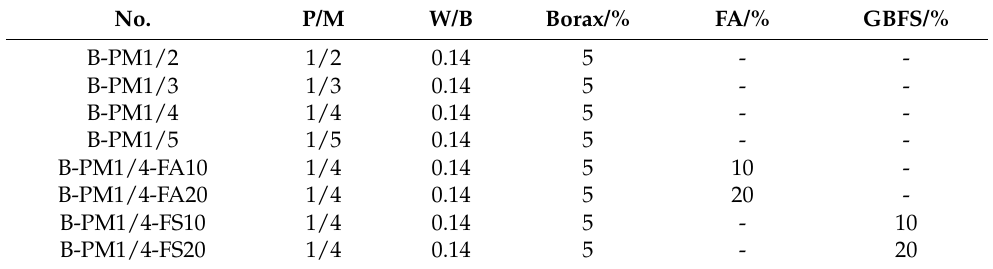
Table 2. The mix proportions of MPC.